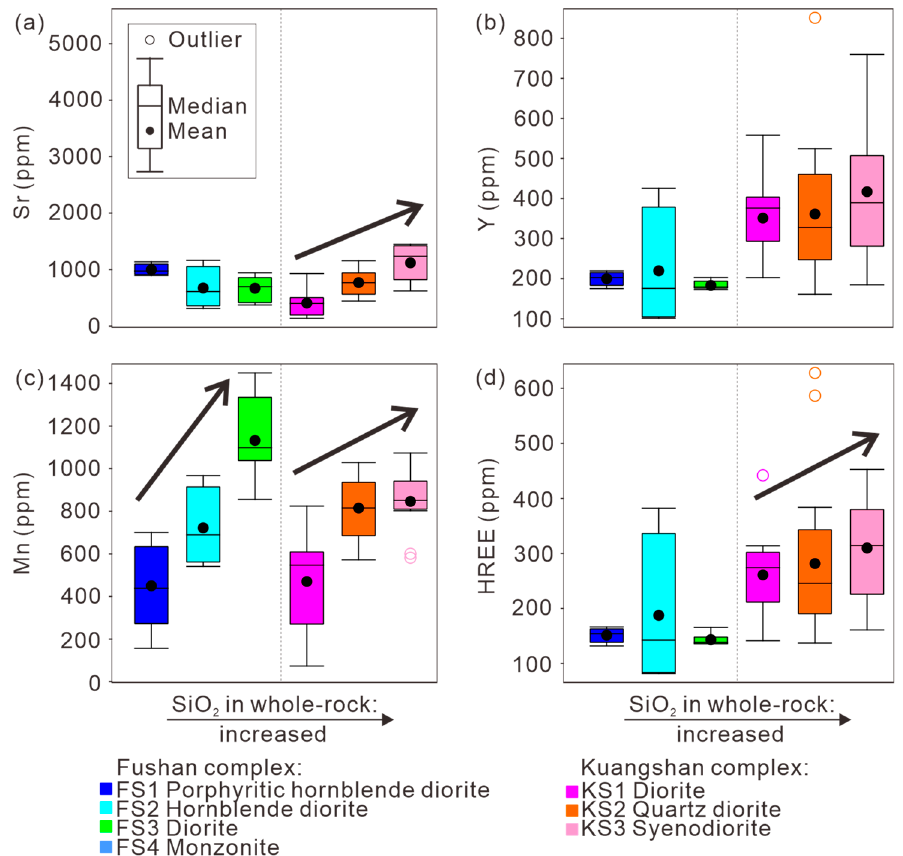
Figure 7. Trace element concentrations in apatite from the Fushan and Kuangshan complexes samples are shown as box and whisker plots. ( a ) Apatite Sr box plot; ( b ) Apatite Y box plot; ( c ) Apatite Mn box plot; ( d ) Apatite HREE box plot.